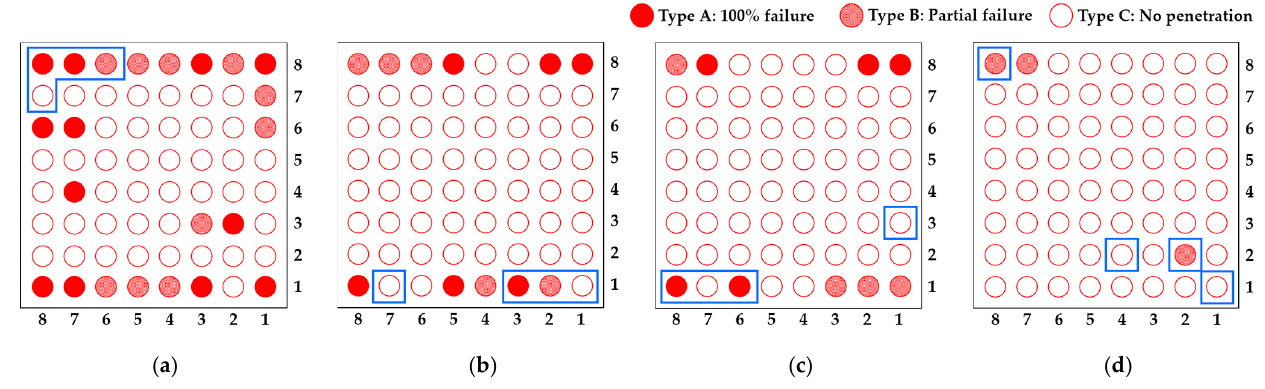
Figure 7. The fracture distribution maps of Sn–Bi/Sn–Bi solder joints and Sn–Bi/TSEP Sn–Bi-x solder joints after a board level drop test. ( a ) Sn–Bi/Sn–Bi U3. ( b ) Sn–Bi/TSEP Sn–Bi-3 U1. ( c )